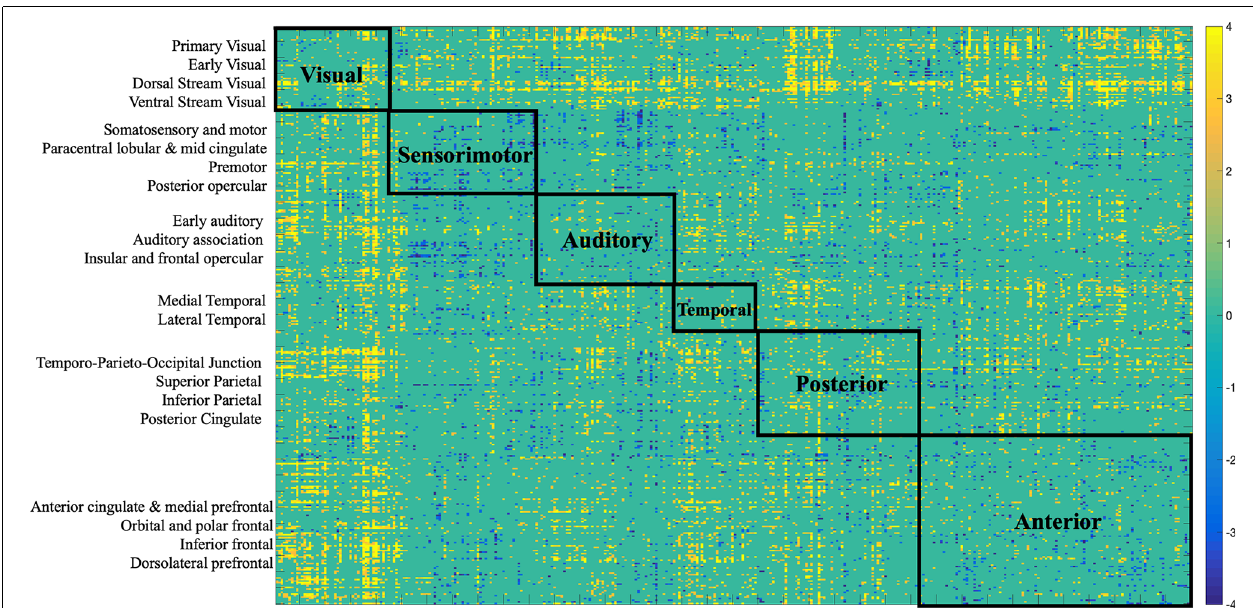
FIGURE 7 | Bootstrap connectivity weights for FC change. Each of the 360 Glasser regions occupies one of the 22 cortices, which are listed on the y-axis. Each cortex was further labeled to a larger partition depicted on the matrix. The assignment is described in detail in Supplementary Neuroanatomical Results in Glasser et al.